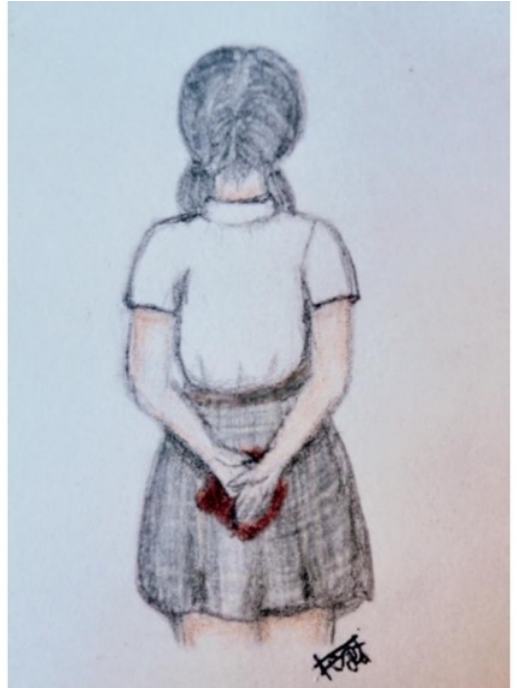
Figure 1 – Author: Celeste